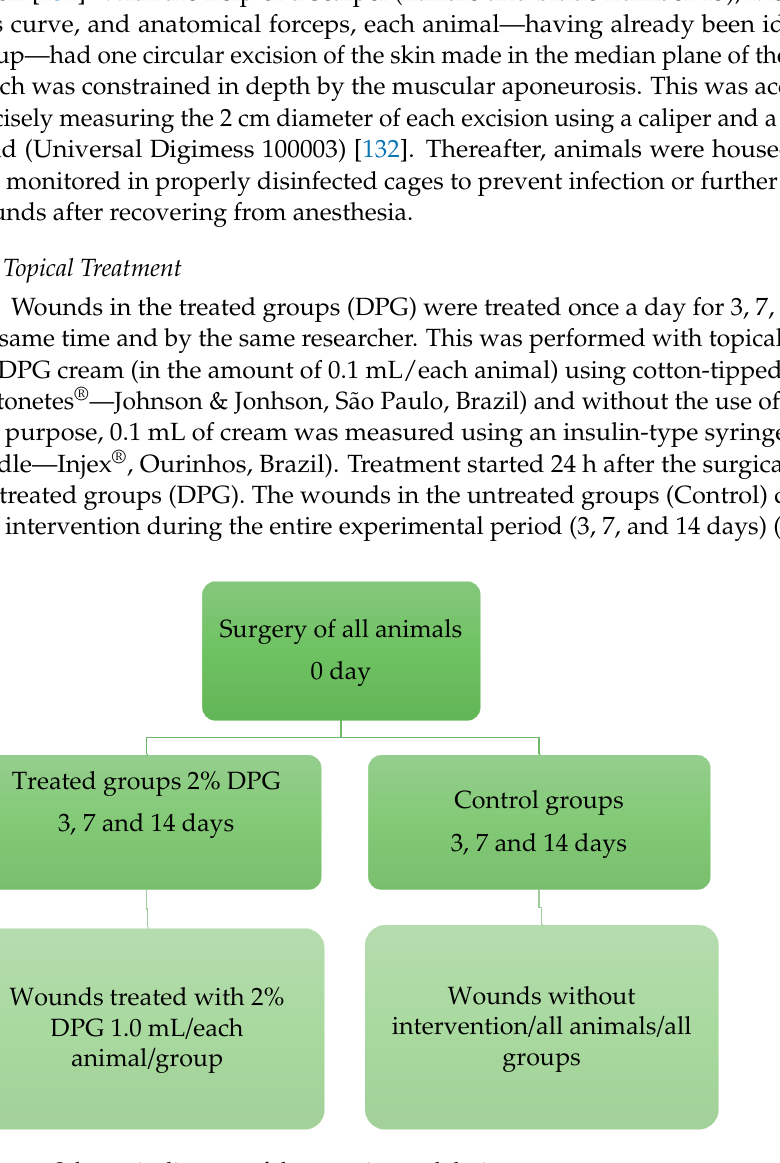
Figure 5. Schematic diagram of the experimental design.